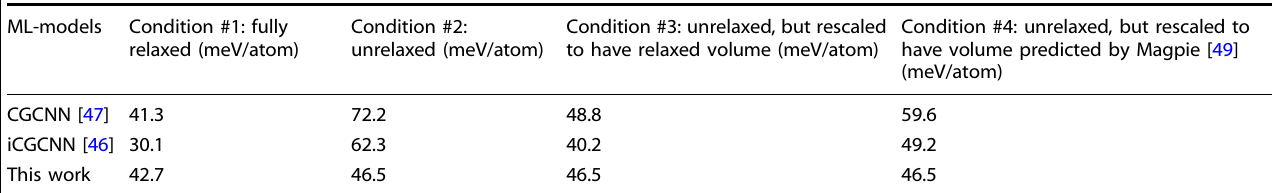
Table 1. Performance test of the machine-learning models under four different conditions. The performances of CGCNN, iCGCNN, and the newly implemented ML model in predicting the formation energy of 230,000 materials in the test set are shown with respect to how relaxed the input crystal structures are prior to constructing the crystal graphs.